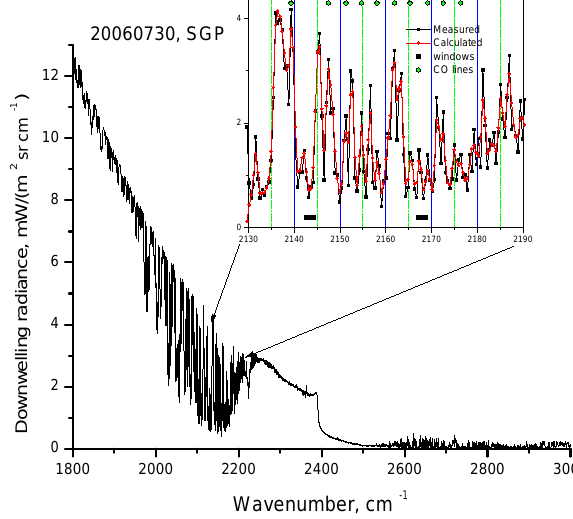
Fig. 1. An example spectrum of atmospheric zenith-sky radiances measured by the SGP AERI on 30 July 2006 at 12:45UTC together with that calculated for the constant CO profile with mixing ratio 78.4ppb (inserted). Green circles indicate locations of CO lines. Black bars correspond to locations of transparent windows used for estimates of scattered solar radiance.